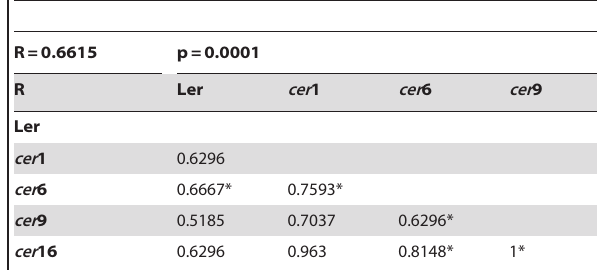
Table 3. Analysis of similarity for bacterial resident communities in the phyllosphere of A. thaliana Ler wild type and four cer mutant lines as analysed by amplicon pyrosequencing.